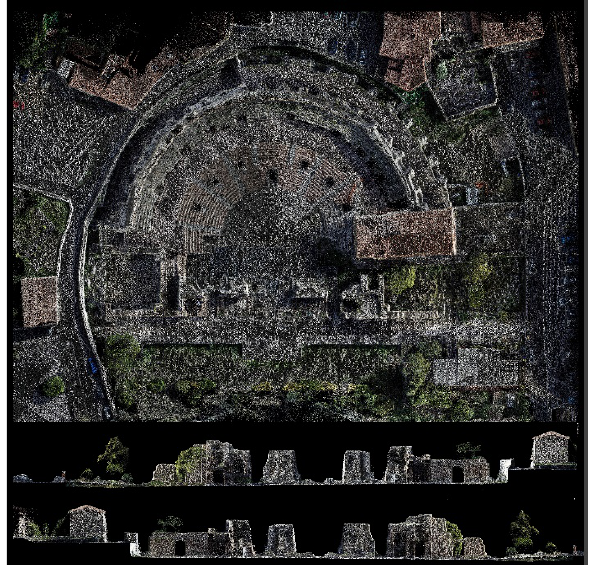
Figur e 7: Orthophotos from the point